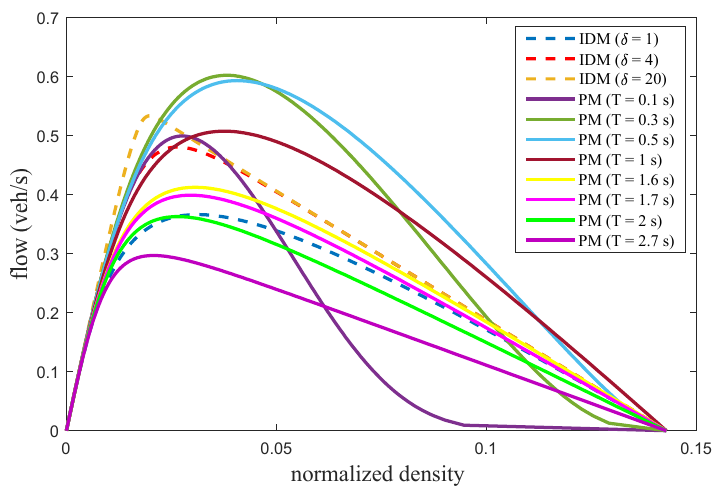
Figure 3. Flow behaviour of the ID and proposed models over a circular road of length 800 m.